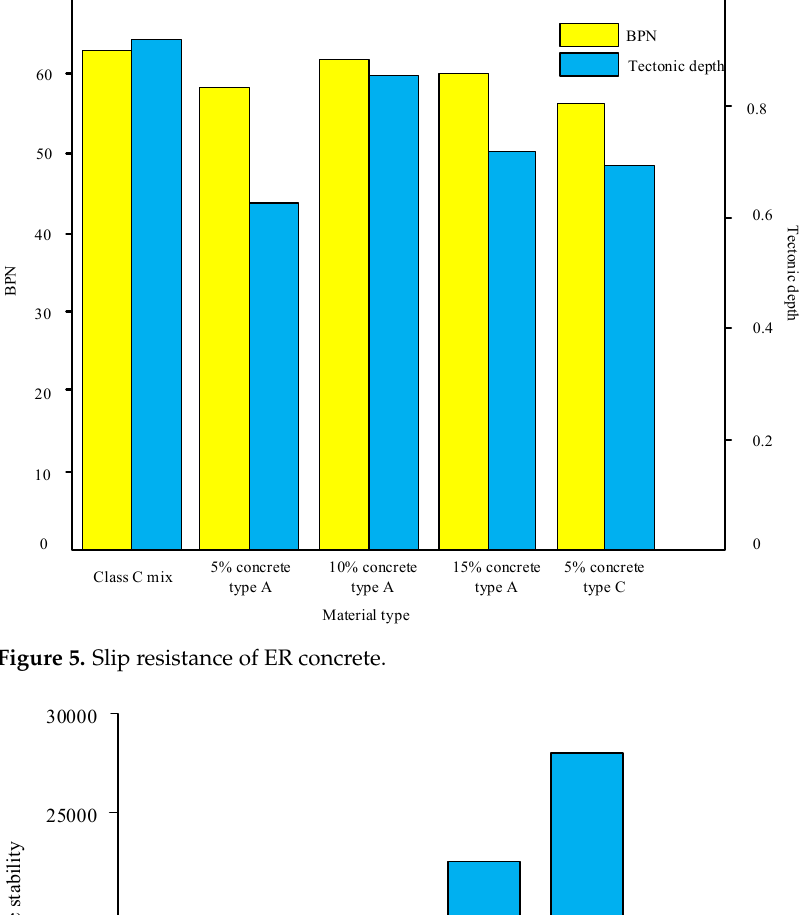
Figure 5. Slip resistance of ER concrete.